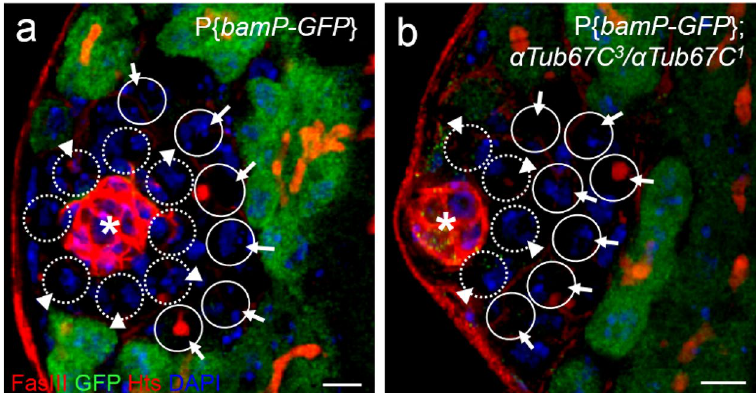
Figure 4. αTub67C fails to affect the expression patterns of bam . The testes were marked with Fas III antibody (red, hub with asterisk), Hts antibody (red, fusomes), GFP antibody (green) and dye DAPI (blue). Testes from bamP-gfp ( a ) and bamP-gfp; αTub67C 3 / αTub67C 1 ( b ) male flies show negative GFP expression in either GSCs (indicated by arrowheads) or GBs (indicated by arrows). GSCs (highlighted by broken lines) can be recognized by their direct contact to hub (marked with asterisk) with DAPI staining (blue, cell nucleus) (Some GSCs can be observed anti-Hts staining). GBs (highlighted by circles) are far away from the hub but surround GSCs with DAPI staining (blue, cell nucleus) (Some GBs can be observed anti-Hts staining). Scale bars: 5